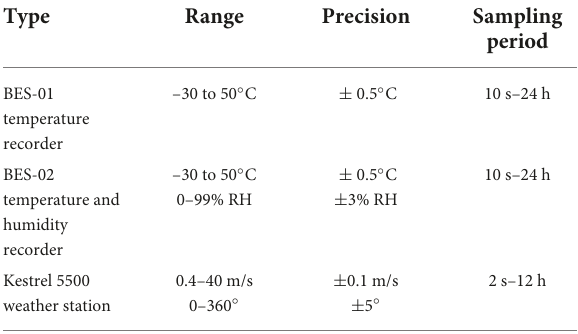
TABLE 1 Characteristics of the measurement